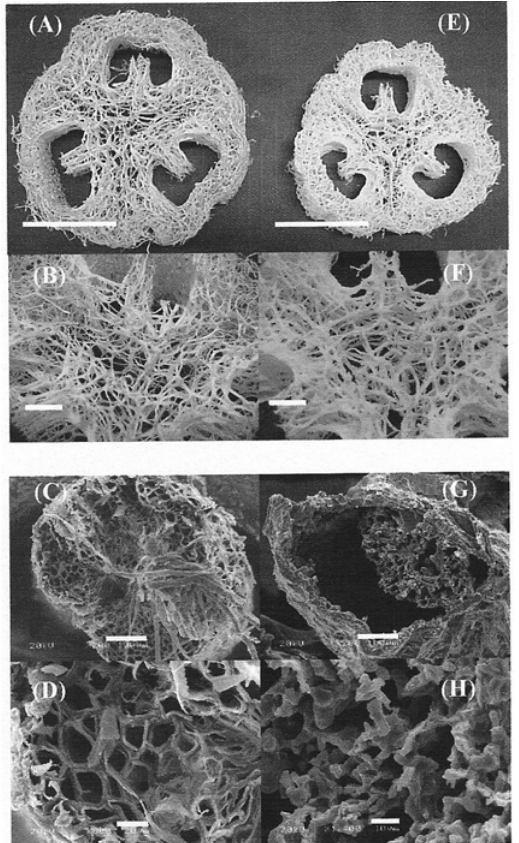
Fig. 2 – Photographs of the fibrous network of the Luffa cylin- drica fruit(A,B;scales5cm,1cm). Cross-sectionalSEMmicro- graphs of the fibers of the Luffa cylindrica (C, D; scales 100 µ m, 20 µ m). Photographs of the calcium carbonate inorganic replica (E, F; scales 5 cm, 1 cm). Cross-section SEM micrographs of the calcium carbonate inorganic replica (G, H; scales 100 µ m, 10 µ m).